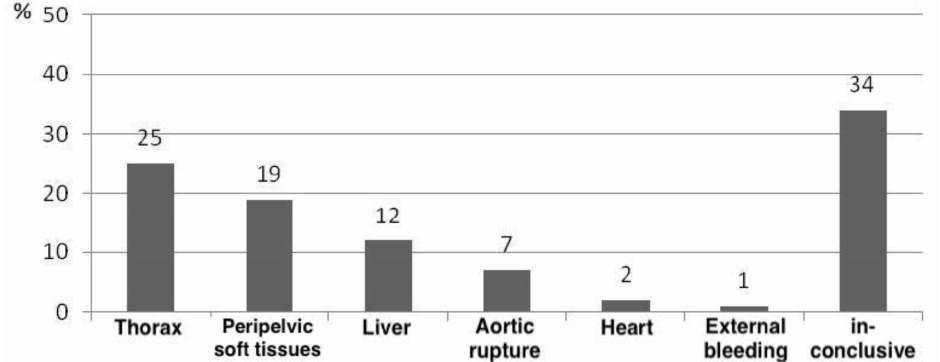
Figure 4. Overview of the main sources of hemorrhage in the examined collective: thoracic (25%, n = 23), followed by peripelvic (19%, n = 17) bleeding, hemorrhage of the liver (12%, n = 11), aortic rupture (7%, n = 6), and destruction of the heart (2%, n = 2). External sources of bleeding—due to transfemoral amputation—occurred in only one case (1%, n = 1). In 34% (n = 31) of the patients, a clear assignment of the main source of bleeding was not possible during autopsy due to multiple injuries. (Source: Haussmann [22], modified).